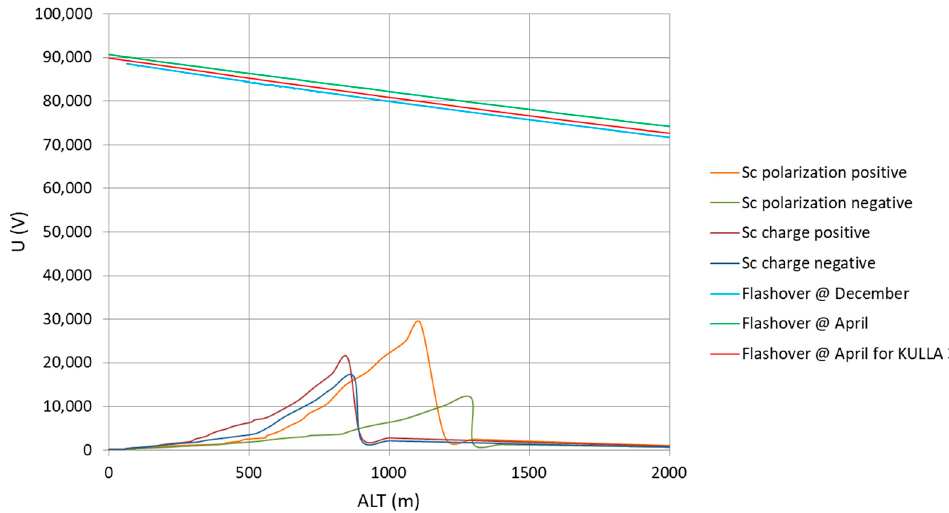
Figure 4. The flashover and induced voltage through the Stratocumulus clouds on the 500 m-long fully airborne antenna during the ascent.